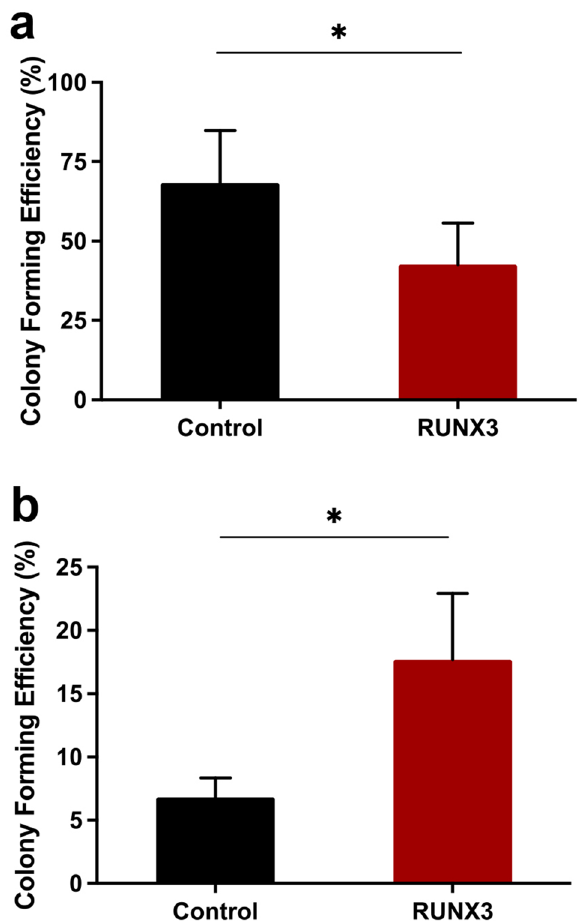
Figure 5. RUNX3 overexpression inhibits erythroid colony formation and increases colony formation in replating assays. ( a ) Erythroid colony forming efficiency of sorted DsRed + CD13 low control and RUNX3- expressing cultures following 7 days of growth in erythroid supporting growth medium containing IL-3, IL-6, SCF and EPO. Data indicate mean ± 1SD (n ≥ 3). No differences were observed in cluster formation between control and RUNX3 cultures (data not shown). ( b ) Self-renewal potential, assessed by a single replating round of control and RUNX3 cultures in the same conditions as previously. Following the initial 7 days of growth, erythroid colonies were counted, harvested and cells were replated in erythroid supporting growth medium containing IL-3, IL-6, SCF and EPO. Replating #1 data indicate mean ± 1SD (n = 3). Significant difference of RUNX3-expressing cells from controls was analysed by paired t-test, * p < 0.05. Replating #2 data was obtained from a single